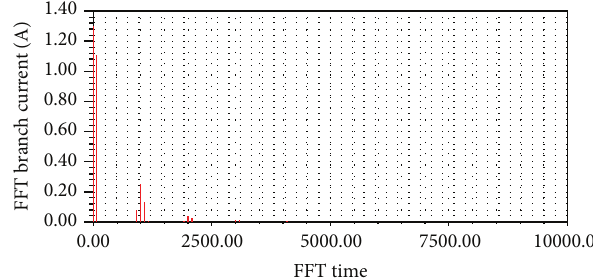
Figure 15: The line-to-line voltage waveform (with LCL filter and capacitor bank).